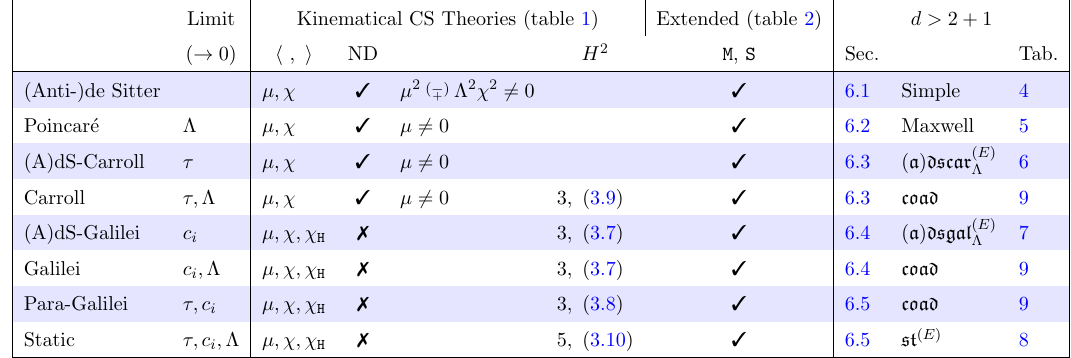
Table 10 . Chern-Simons theories that arise from a limit of